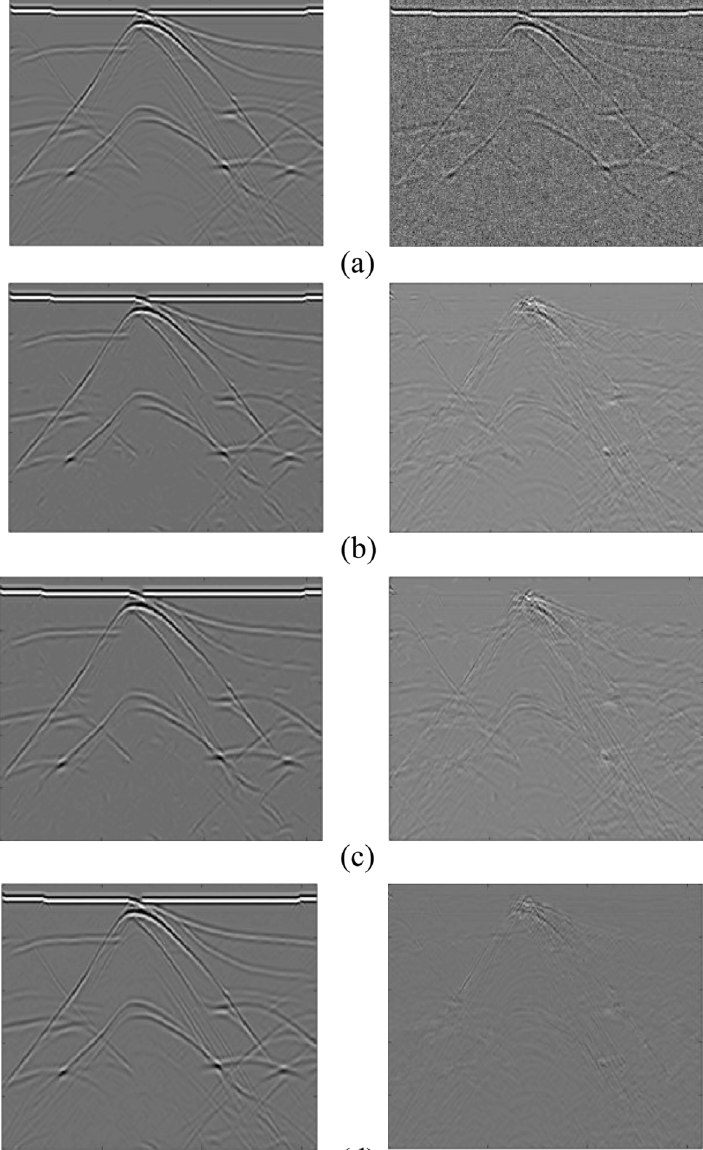
Fig. 7 Visual results of seismic signal denoising. a left panel: clean signals without noise, right panel: the signals with added white noise; b denoised signals (left panel) by RDN and its differences (right panel) with clean signals in ( a ); c and d same as ( b ) but for MSRN and the proposed method,